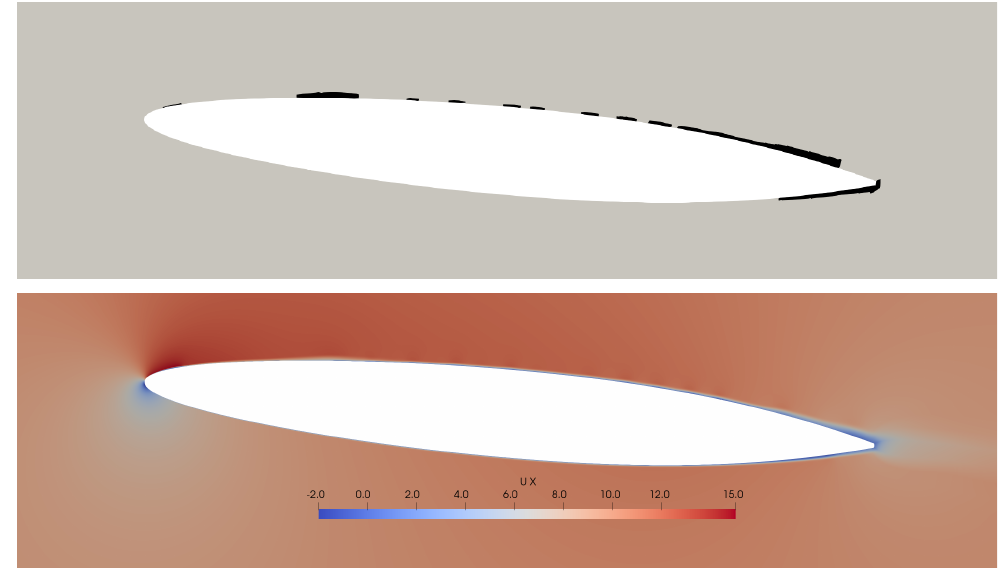
Figure 9. Predicted non-cavitating SepInd (marked in black) and streamwise velocity at Reynolds number of 1,000,000, 2D simulation.